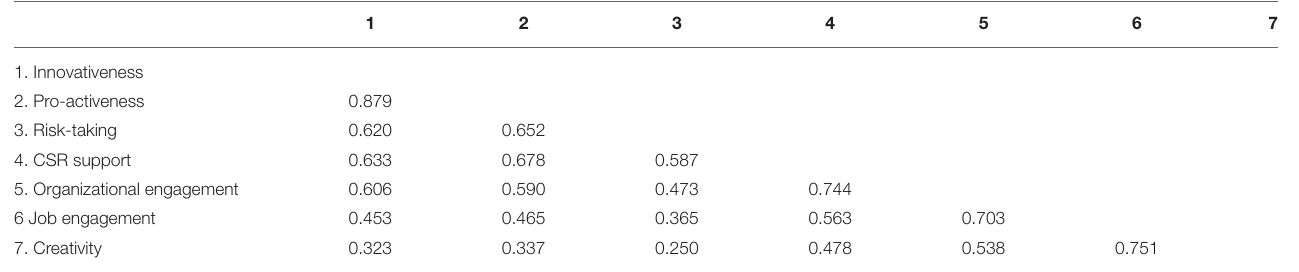
TABLE 3 | Heterotrait-Monotrait ratio